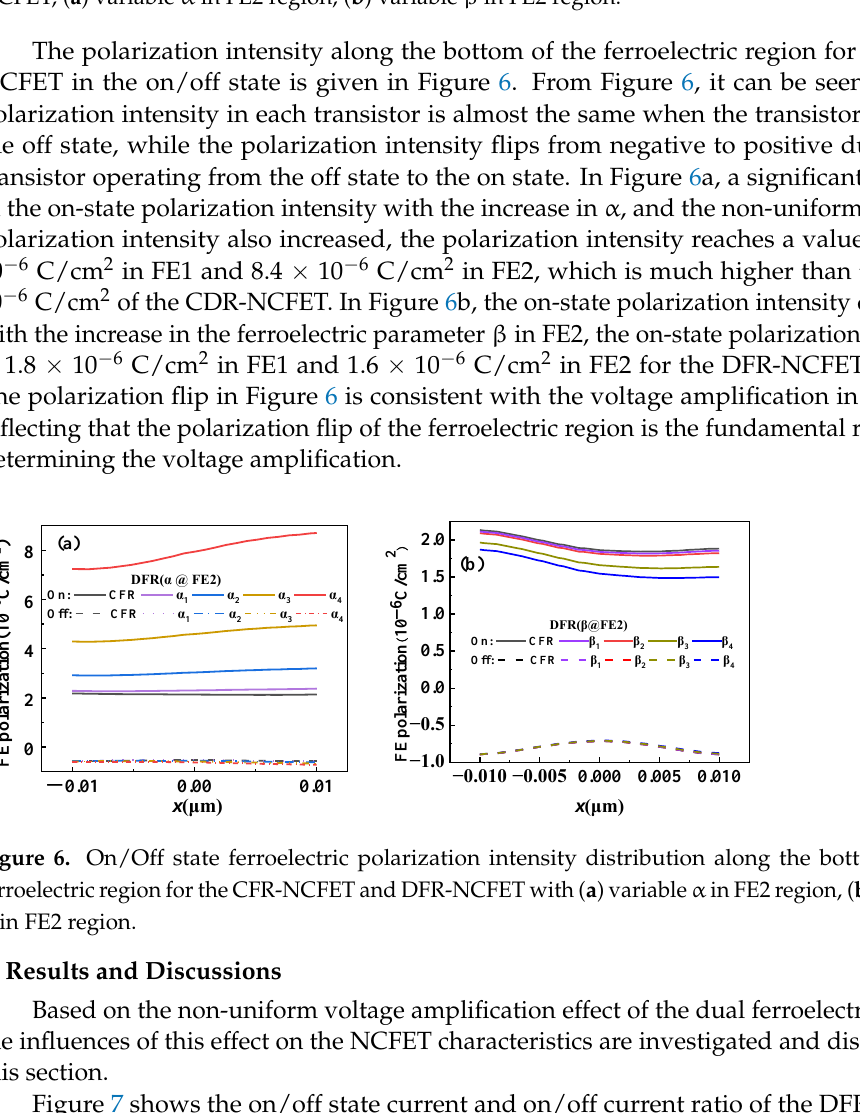
Figure 6. On/Off state ferroelectric polarization intensity distribution along the bottom of the ferroelectric region for the CFR-NCFET and DFR-NCFET with ( a ) variable α in FE2 region, ( b ) variable β in FE2 region.